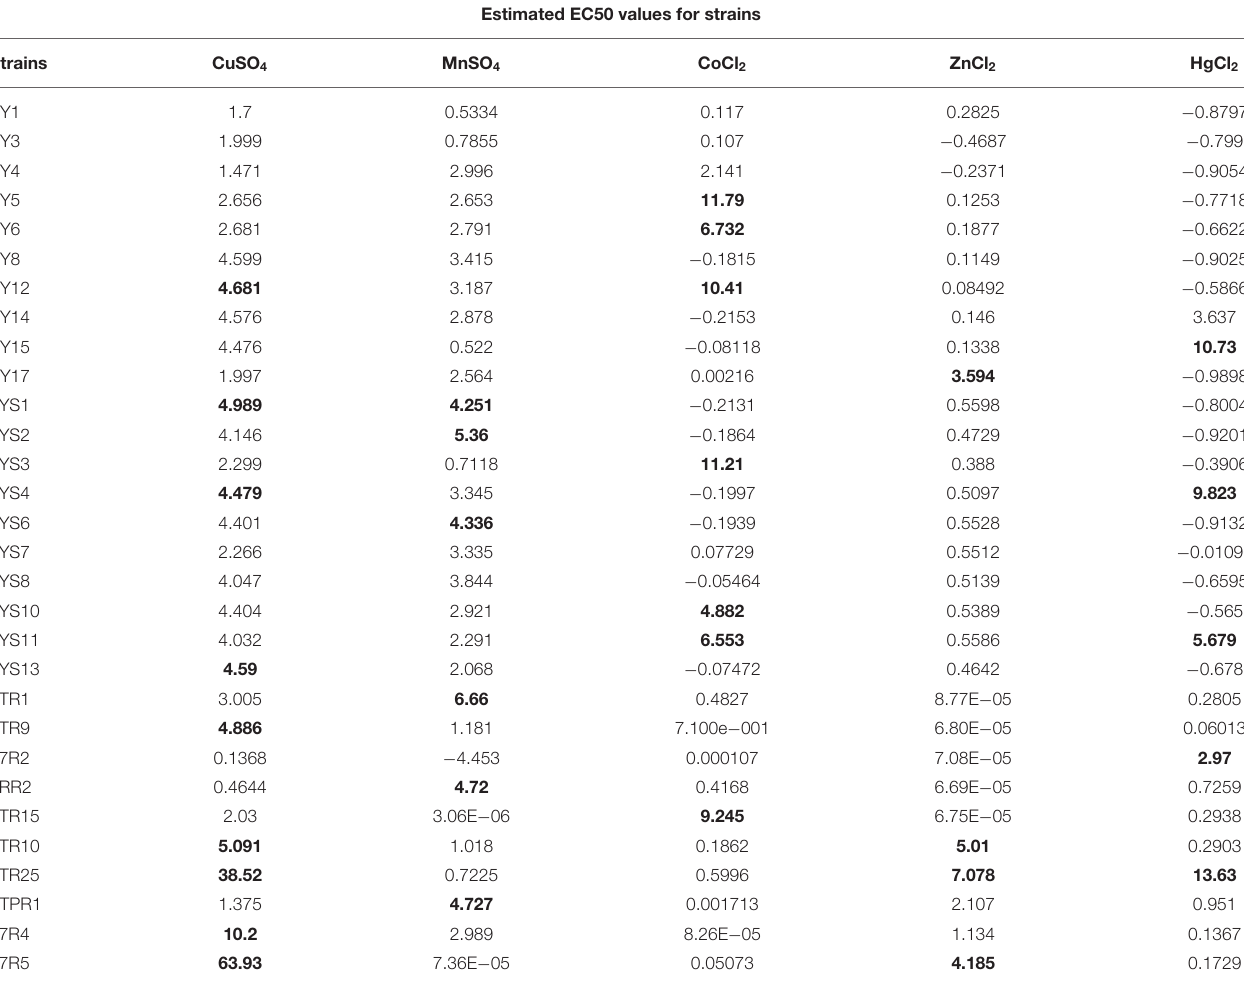
TABLE 4 | Estimated EC50 values for bacterial isolates.